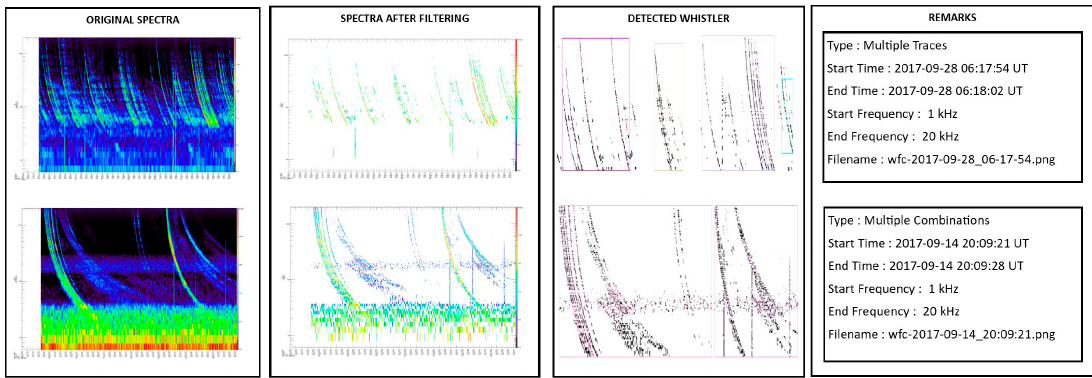
Figure 10. The detected nose, short, middle, and long whistler types.